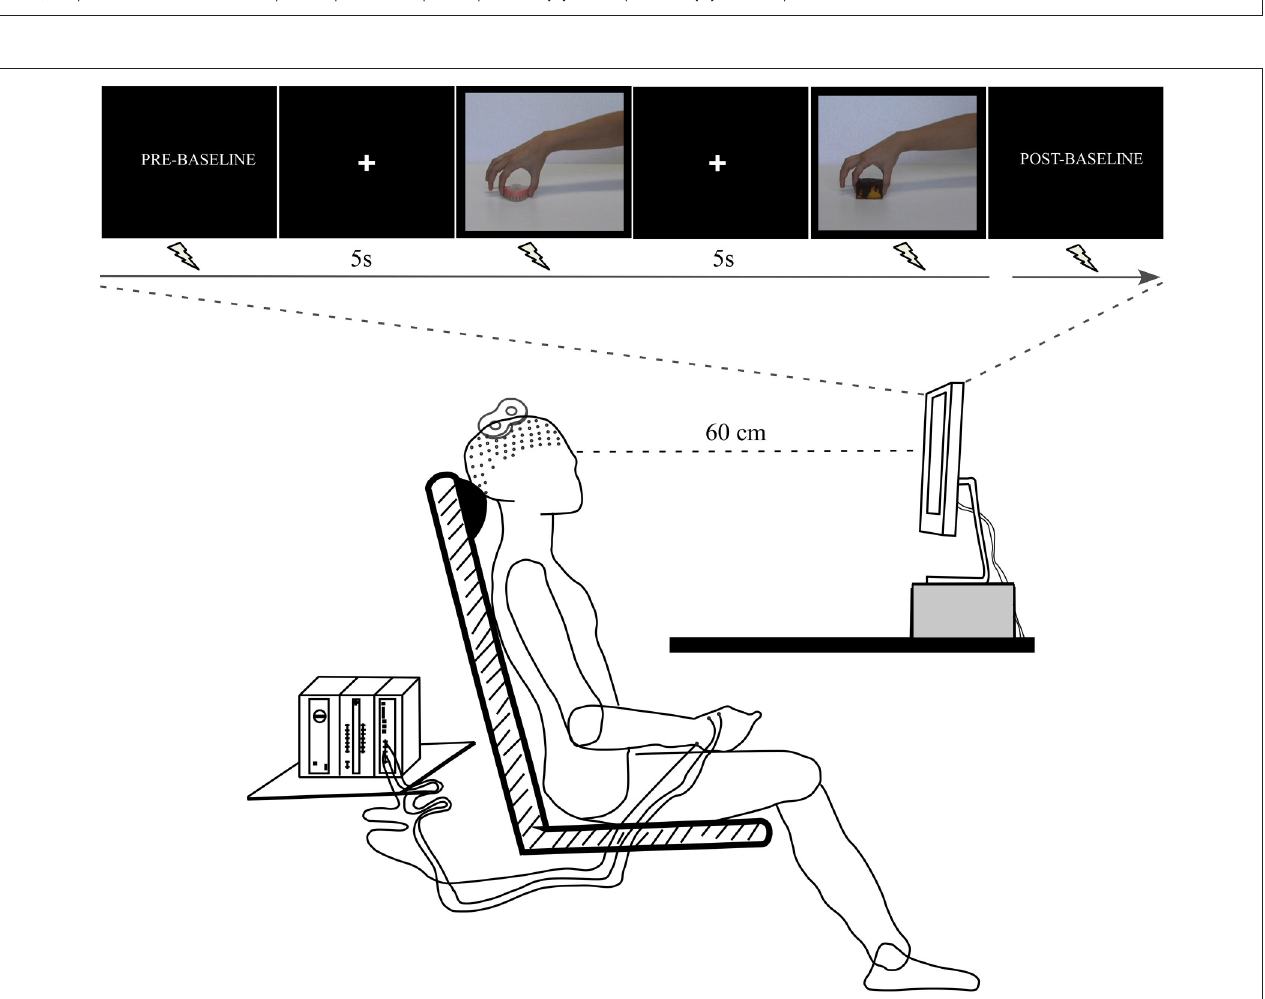
FIGURE 2 | Experimental procedure. The participant sat at a table where a computer screen was positioned. The arms remained at rest throughout the experimental session. The TMS coil was placed over the left motor cortex. The electromyographic (EMG) signal was recorded from right first dorsal interosseus (FDI)